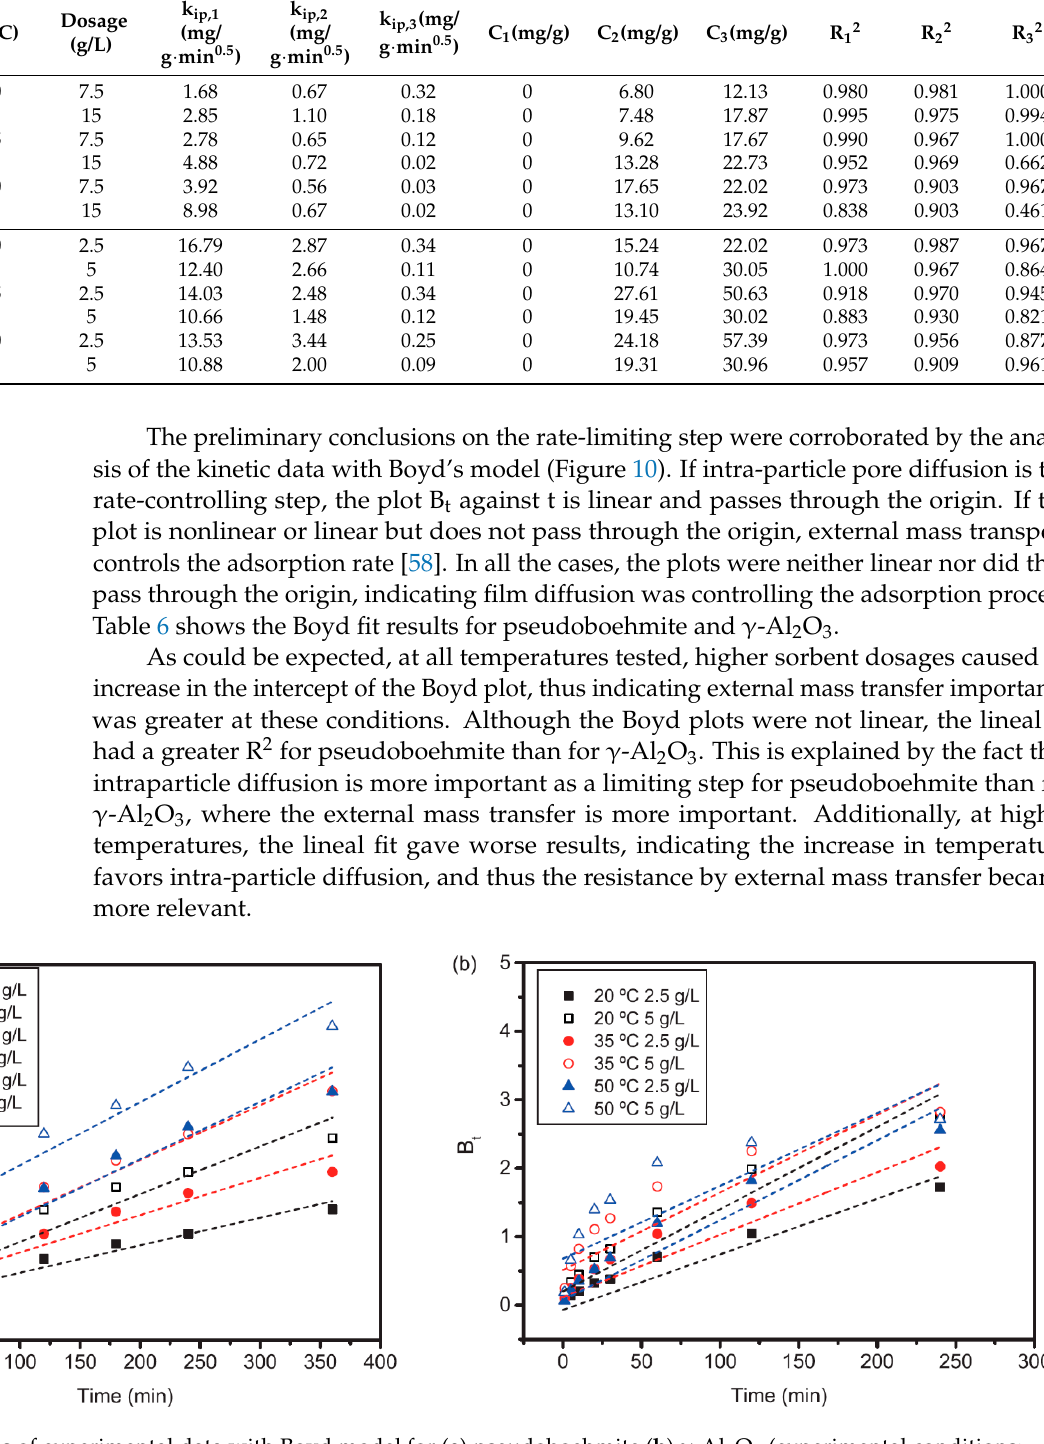
Figure 10. Analysis of experimental data with Boyd model for ( a ) pseudoboehmite ( b ) γ -Al 2 O 3 (experimental conditions: initial pH 8.5, dosages and temperatures in the legend).